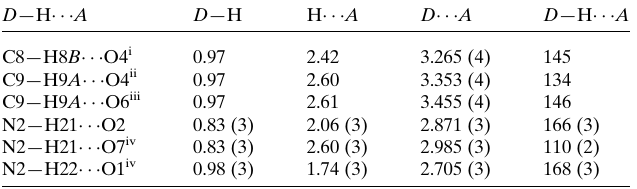
(12) rings exhibit 4 (10) rings 4